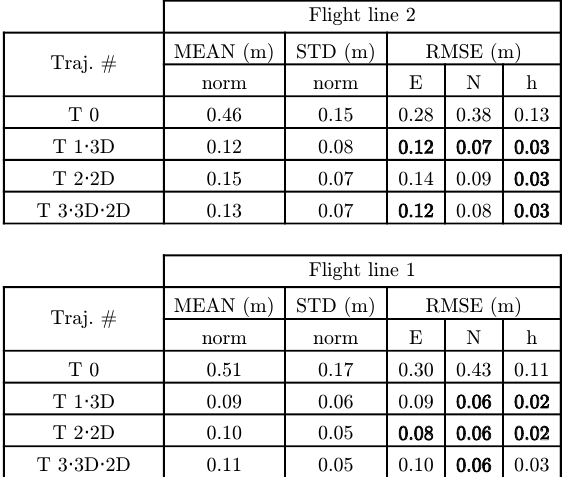
Table 3. Statistics of the geo-referencing error of each computed point-cloud. The best trajectory for each RMSE metric (column) is highlighted in bold.